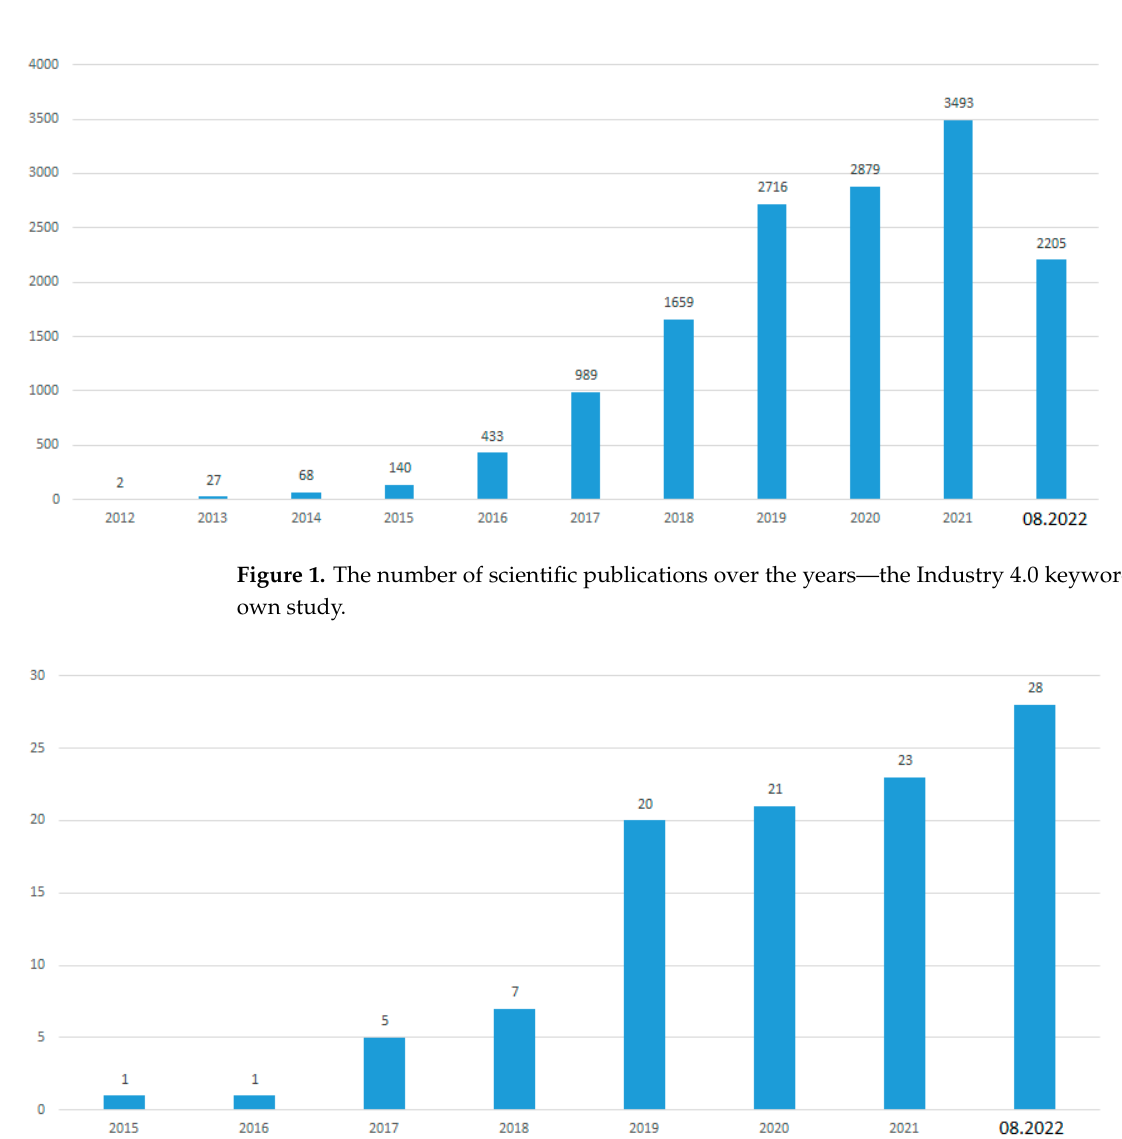
Figure 2. The number of scientific publications over the years—the Logistics 4.0 keyword. Source: own study.